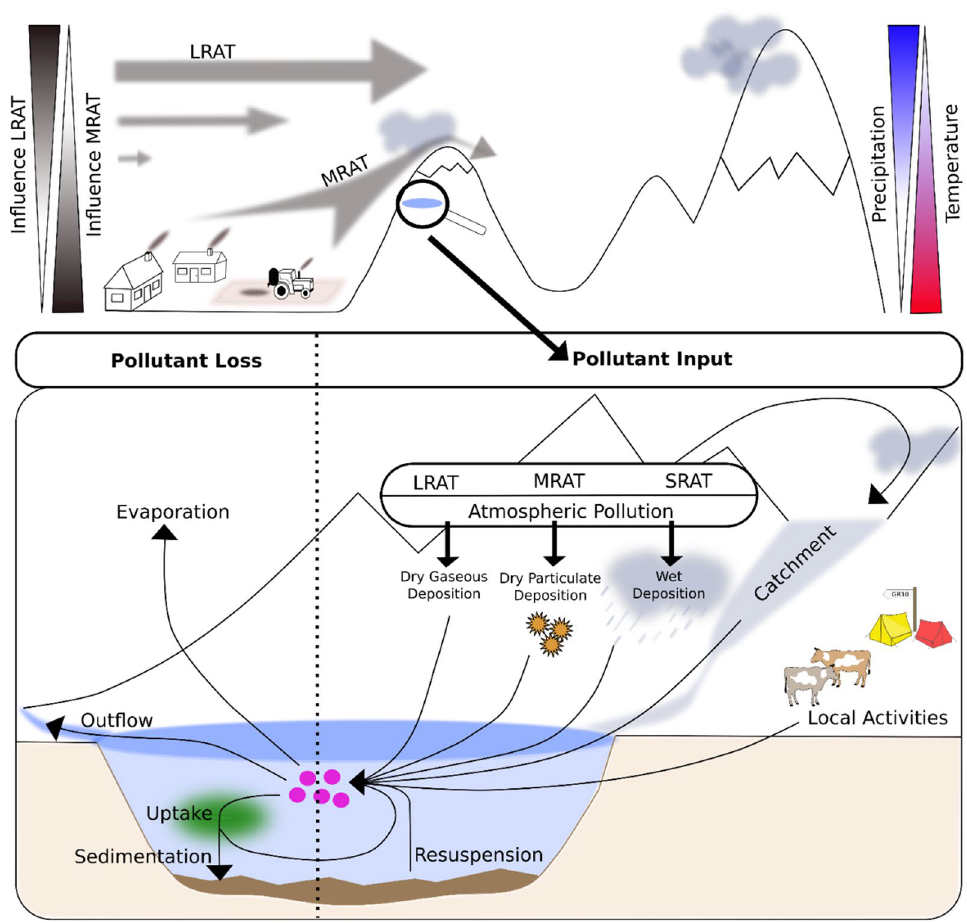
Fig. 2 Atmospheric transport of organic pollutants into mountain environments, and the input and loss of organic chemicals from the waters of mountain lakes. Included pollutants sources are atmospherically deposited pollutants that directly or indirectly introduced into mountain lakes, as well as pollutants from local activities like pastoralism and tourism. Not displayed are degradation processes or topographic and climatic features that can also affect pollutant transport and deposition, as well as their accumulation in lakes. LRAT long-range atmospheric transport; MRAT medium-range atmospheric transport; and SRAT short-range atmospheric transport (e.g., local